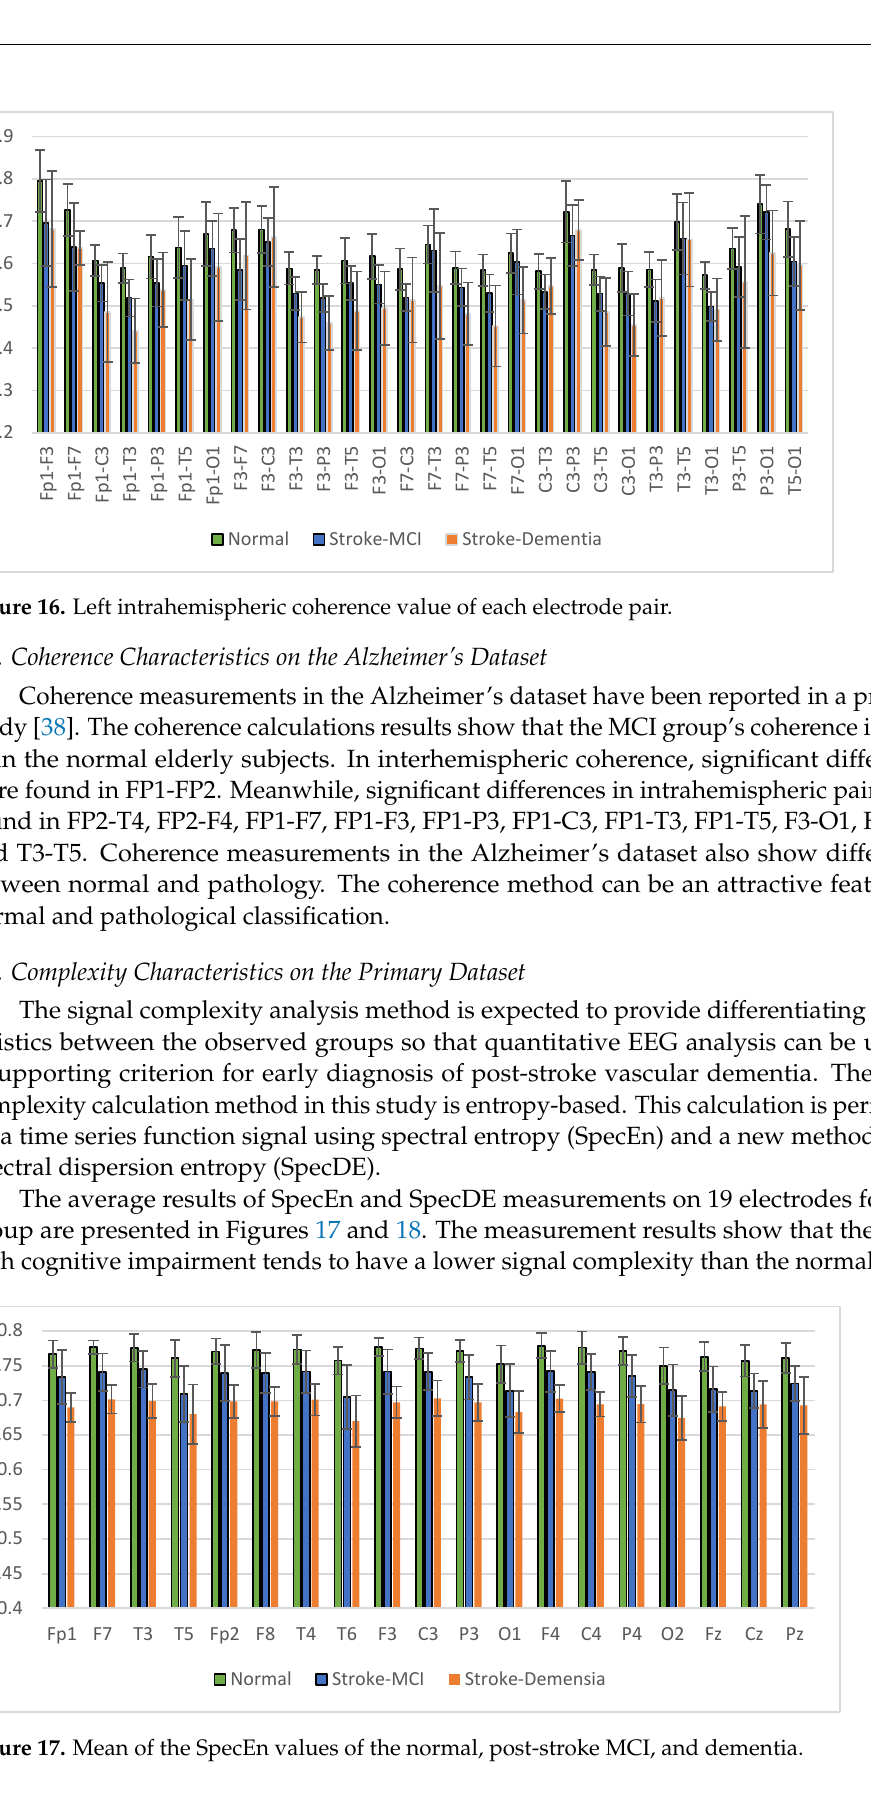
Figure 18. Mean of the SpecDE values of the normal, post-stroke MCI, and dementia. 3.6. Complexity Characteristics on the Alzheimer’s Dataset The results of the SpecEn calculations in the Alzheimer ’ s dataset are presented in Figure 19. Figure 19 shows that the SpecEn values in the MCI group generally tend to be lower than the normal group. Significant differences were found in Fp1, Fp2, T6, and O1. These results indicate a decrease in EEG signal complexity in MCI patients. These charac- teristics are similar to post-stroke patients with cognitive impairment. From these results, it is hoped that the degree of complexity can be a reliable feature for discrimination be- tween normal subjects and patients with cognitive impairment.